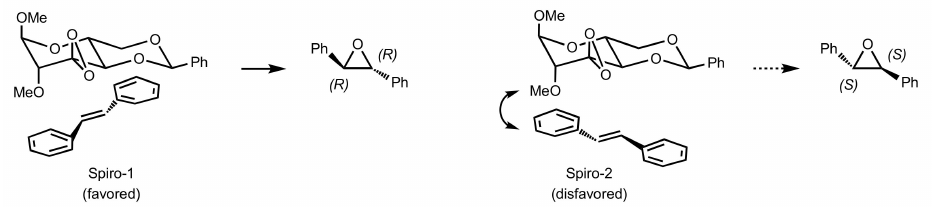
Figure 22. The proposed transition states for the epoxidation of trans -stilbene catalysed by 261a . A similar approach was used by Davis and co-workers [138] who directed their efforts towards the design and synthesis of a set of N -acyl-glucosamine ketones for the epoxidation of challenging substrates [100,113], such as 2,2-disubstituted and terminal olefins. The commercially available N -acetyl- D -glucosamine 266 was first glycosidated with methanol and protected as 4,6- O -benzylidene acetal to give 267 , then the latter was submitted to the Swern oxidation to afford 268 (Scheme 72) [138]. The acetamido derivative 267 was also hydrolyzed under basic conditions, and the resulting 2-amino sugar was acylated with variously substituted benzoyl chlorides to give 269a-e . Oxidation of these products afforded the desired ketones 270a-e in a moderate to excellent yield (Scheme